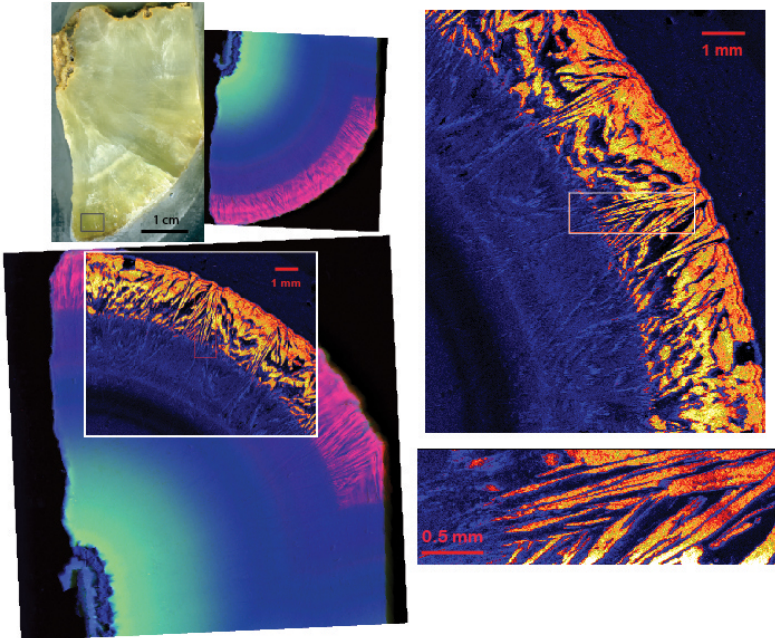
Figure 18. Slab of the dolomite with on-the-fly synchrotron XRF images. The rectangle at the bottom of the sample is the approximate location of the LA maps in Fig. 21. Directly to the right of the slab image is an RGB (U Sr Ca) map from beamline XFM at the NSLS II. The images on the right are maps of U from TES. On the lower left, the TES U map is overlain on the same area that was mapped at XFM. The XFM mapping was done at 17keV with a 10µm beam, a 10µm step size, and a counting time of 0.1s. The large TES map was made at 3550eV with an 18µm beam and 20µm pixels, counting for 0.3s. The detail map on the bottom right was also made at 3550eV with a 4µm beam and 3.75µm pixels, counting for 0.3s.